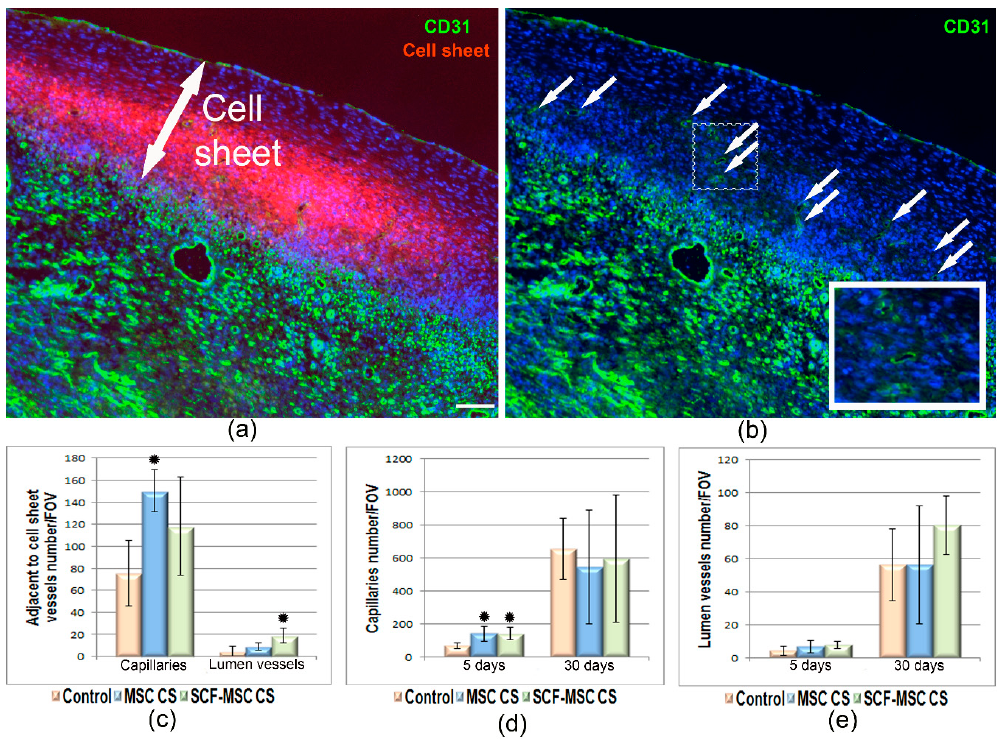
Figure 6. Vascularization of ischemic myocardium at day 5 and 14 after MSC sheet transplantation. ( a , b ) Representative images of CD31 positive vascular structures (green) in ischemic myocardium covered by CS comprised of pre-labelled MSC (red). Day 14 after MI induction. Nuclei are stained with DAPI (blue). White arrows ( b ) indicate vascular structures present in the cell sheet. ( c ) Capillaries and lumen vessel count in FOVs covering the adjacent to CS region. The black asterisk ( ⁕ ) indicates statistical significance vs. control group; ( d ) Capillaries vessel count. The black asterisk ( ⁕ ) indicates statistical significance vs. control group; ( e ) Lumen vessel count. Data are presented as mean ± SD (Mann–Whitney U-test). Scale bar-100 µm.